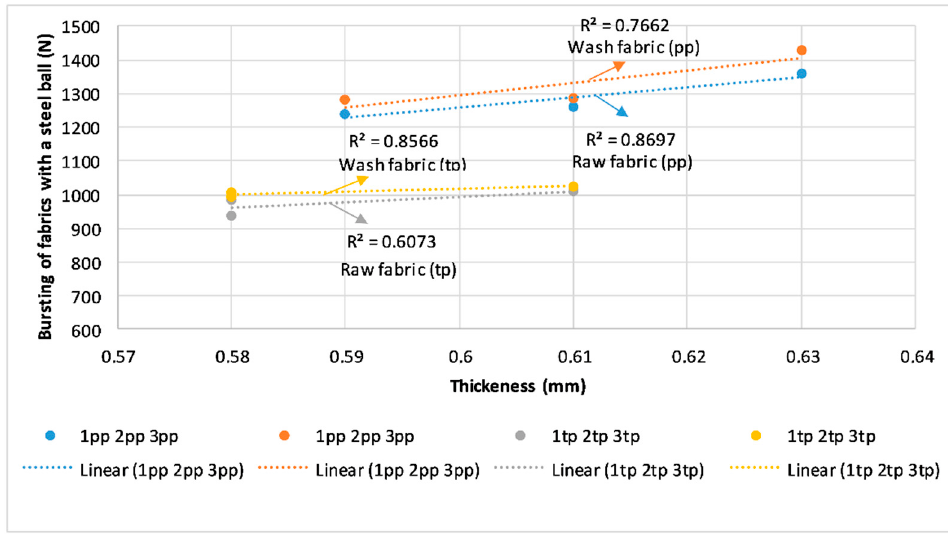
Figure 11. Coefficient of determination and regression between the bursting of woven fabrics (N) and thickness of the fabrics (mm).